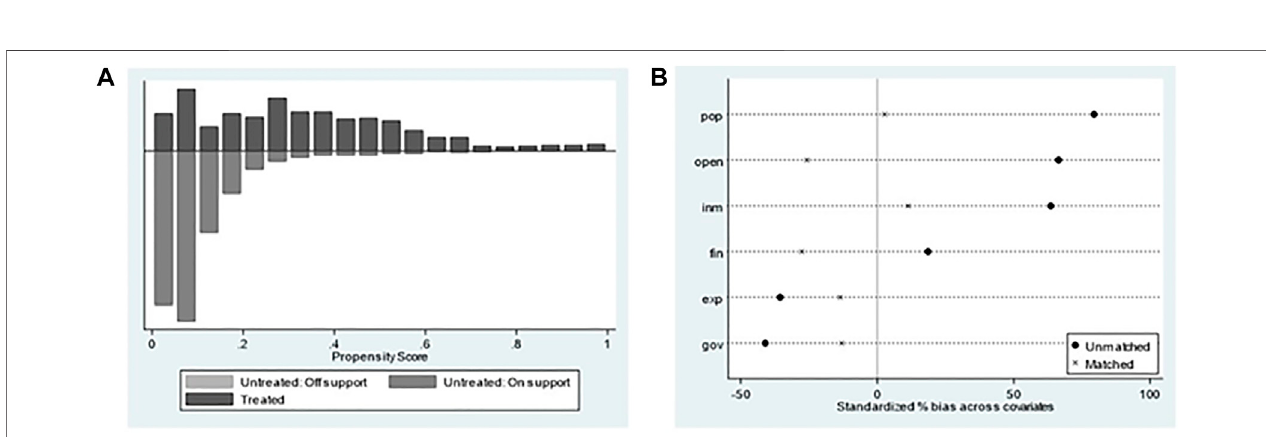
FIGURE 4 | Common support hypothesis testing. (A) Common value range of propensity score matching; (B) The standardization of control variables before and after matching.